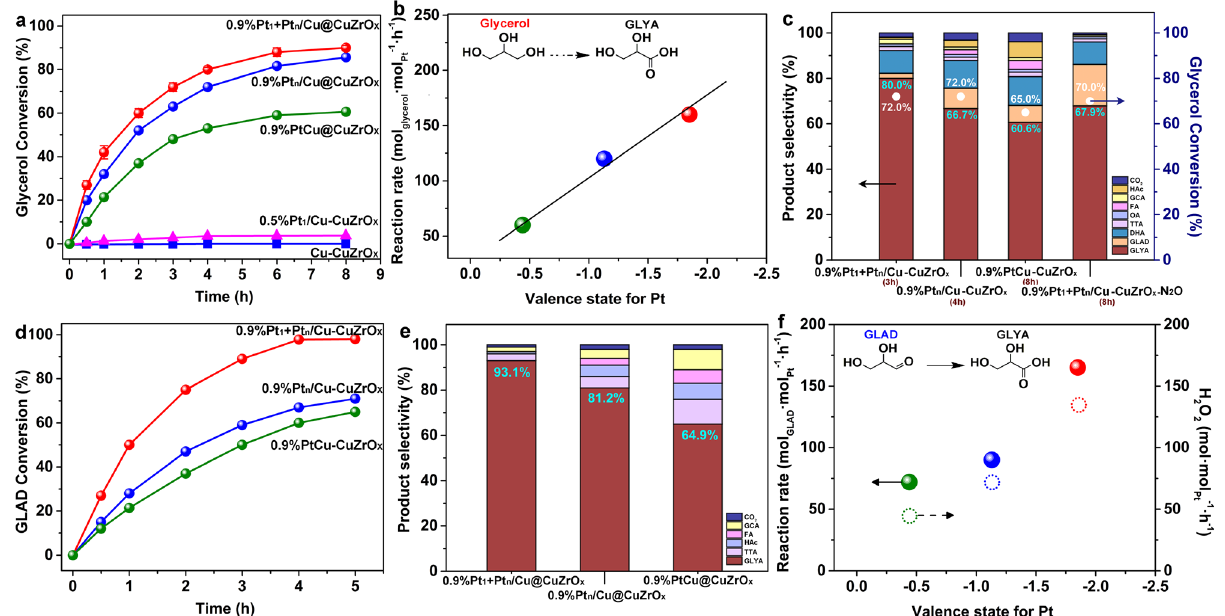
Fig. 9 | Pt electronic structure and the catalytic evaluation. a – c In the selective oxidationof glycerol, time-dependent glycerol conversion ( a ), pro fi le of glycerol conversionratewithPtvalencestate( b ),andcomparisonofproductselectivityat similar glycerol conversion ( c ). d – f In the selective oxidation of GLAD, time- dependent GLAD conversion ( d ), comparison of product selectivity ( e ), and